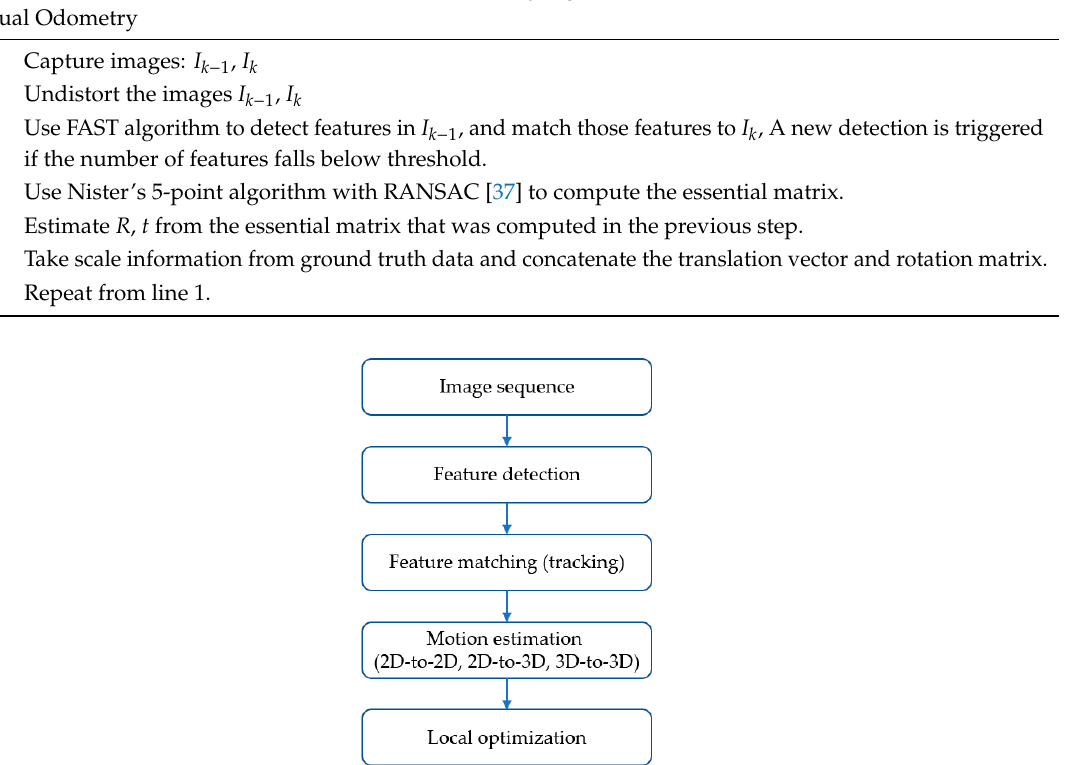
Algorithm 1 Pseudo-code of Monocular Visual Odometry algorithm [2,36]. 2D-to-2D Monocular